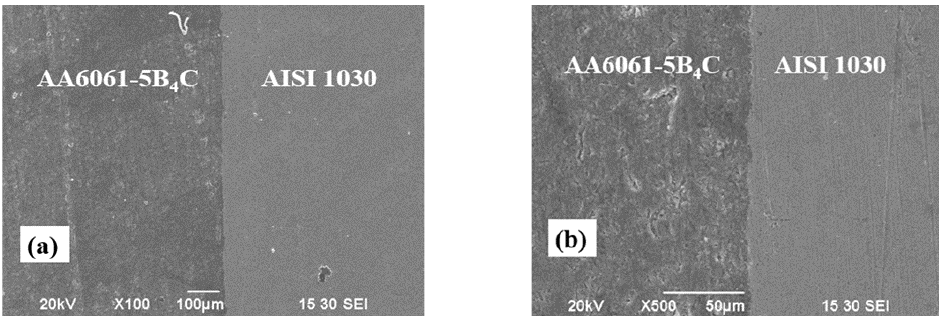
Figure 8. Scanning electron micrograph at the interface of the welded joint at the normal condition at 1600 rpm, ( a ) at a magnification of 100× and ( b ) at a magnification of 500×.